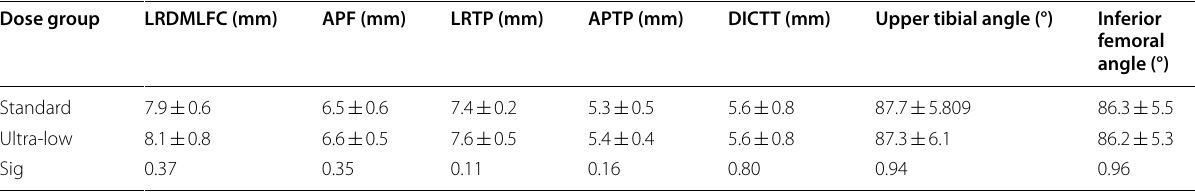
Table 4 Measurement parameters of CT imaging Dose